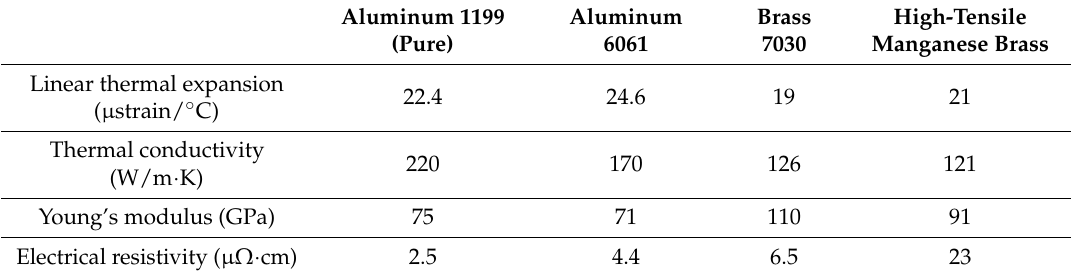
Table 1. Comparison of the selected